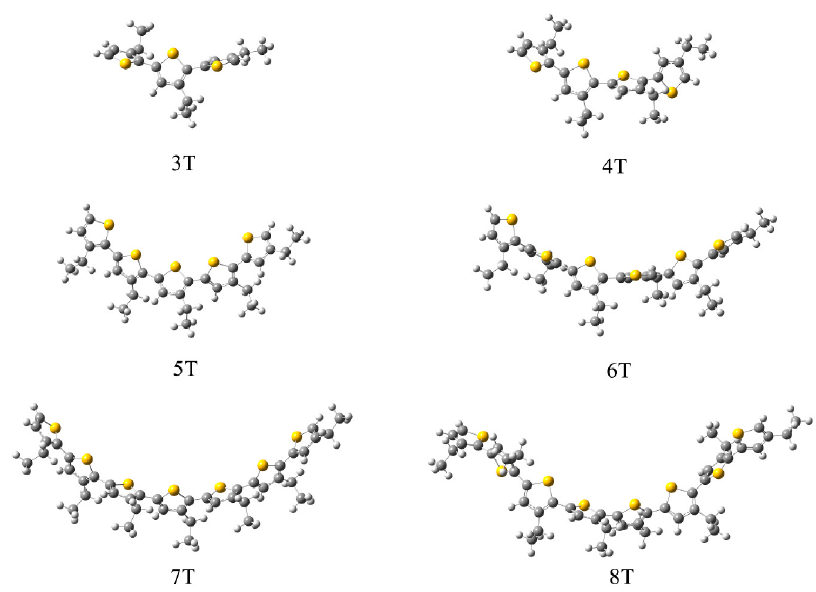
Figure 6. The QM optimized curved conformation of the ethyl-substituted P3ATs. Table 1. The torsion angles between the neighboring thiophene rings and the degrees of